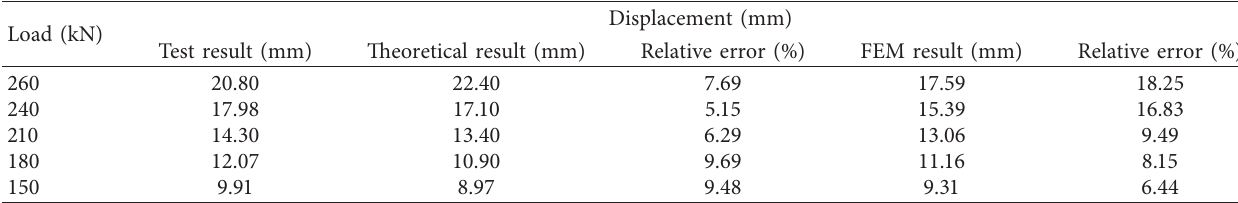
Table 6: Comparison of horizontal displacements at the top of columns.